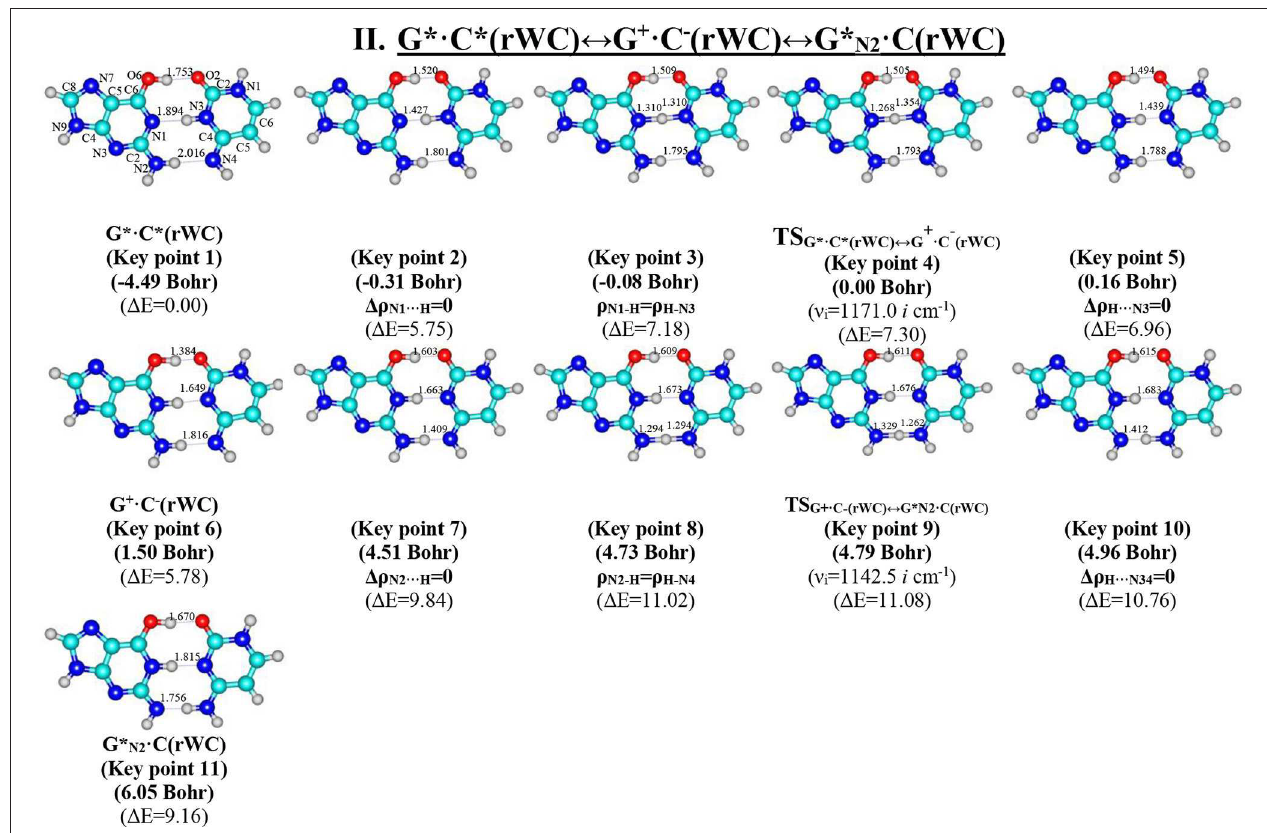
FIGURE 4 | Geometric structures of the 11 key points describing the evolution of the II. G* SPT along the IRC obtained at the B3LYP/6-311